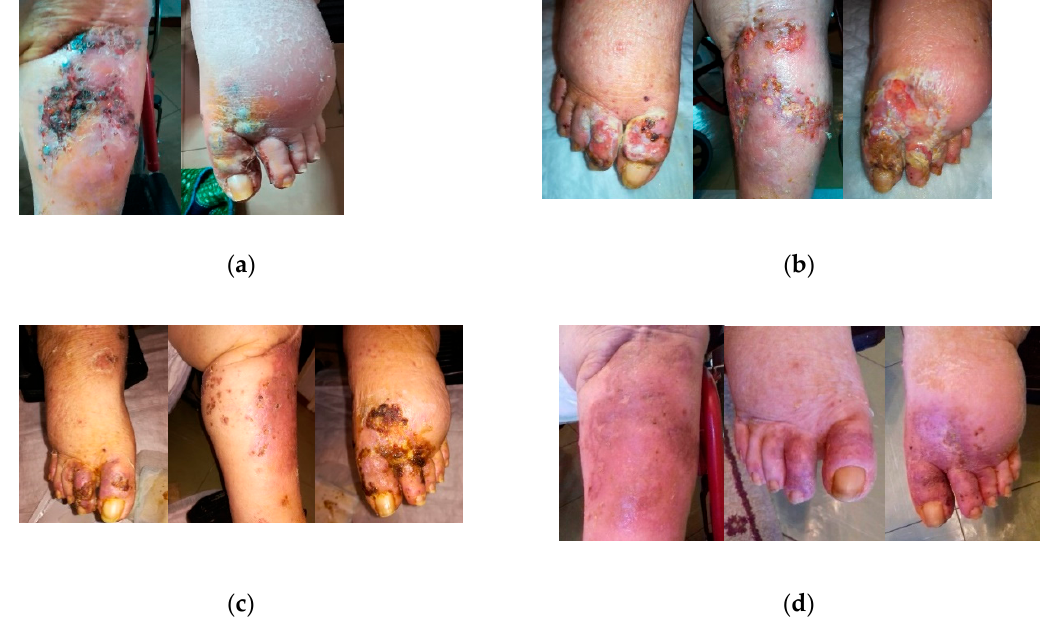
Figure 6. Case 6: ( a ) the wound at the start of MGH therapy (day 0); ( b ) MGH therapy led to autolytic debridement of necrotic tissue at day 12; ( c ) after one month, the edema was reduced and wound healing progressed; ( d ) complete healing of the wounds after seven weeks of MGH therapy.